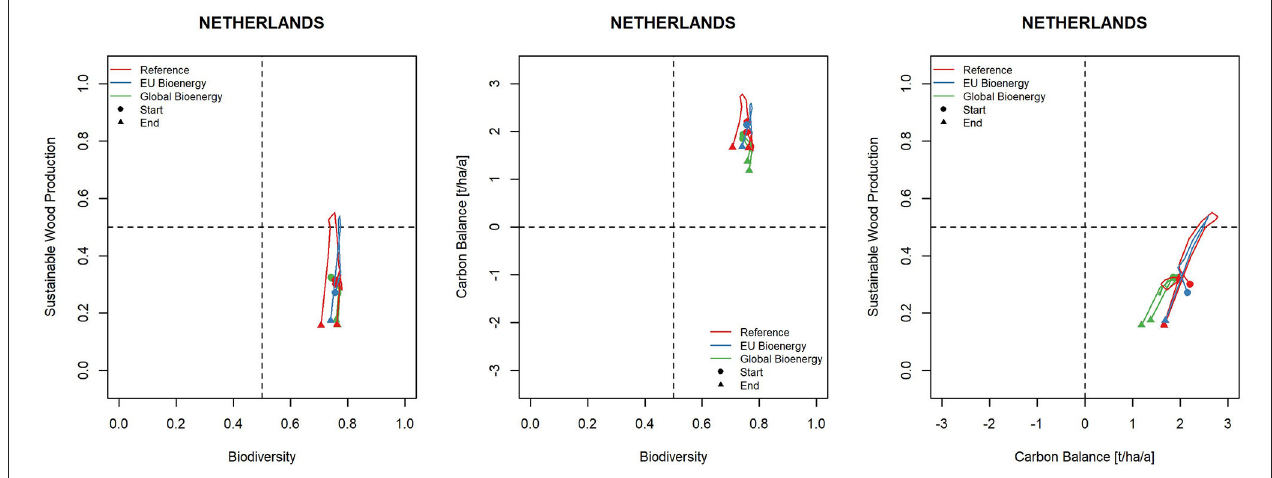
FIGURE 5 | Trade-off diagrams for the